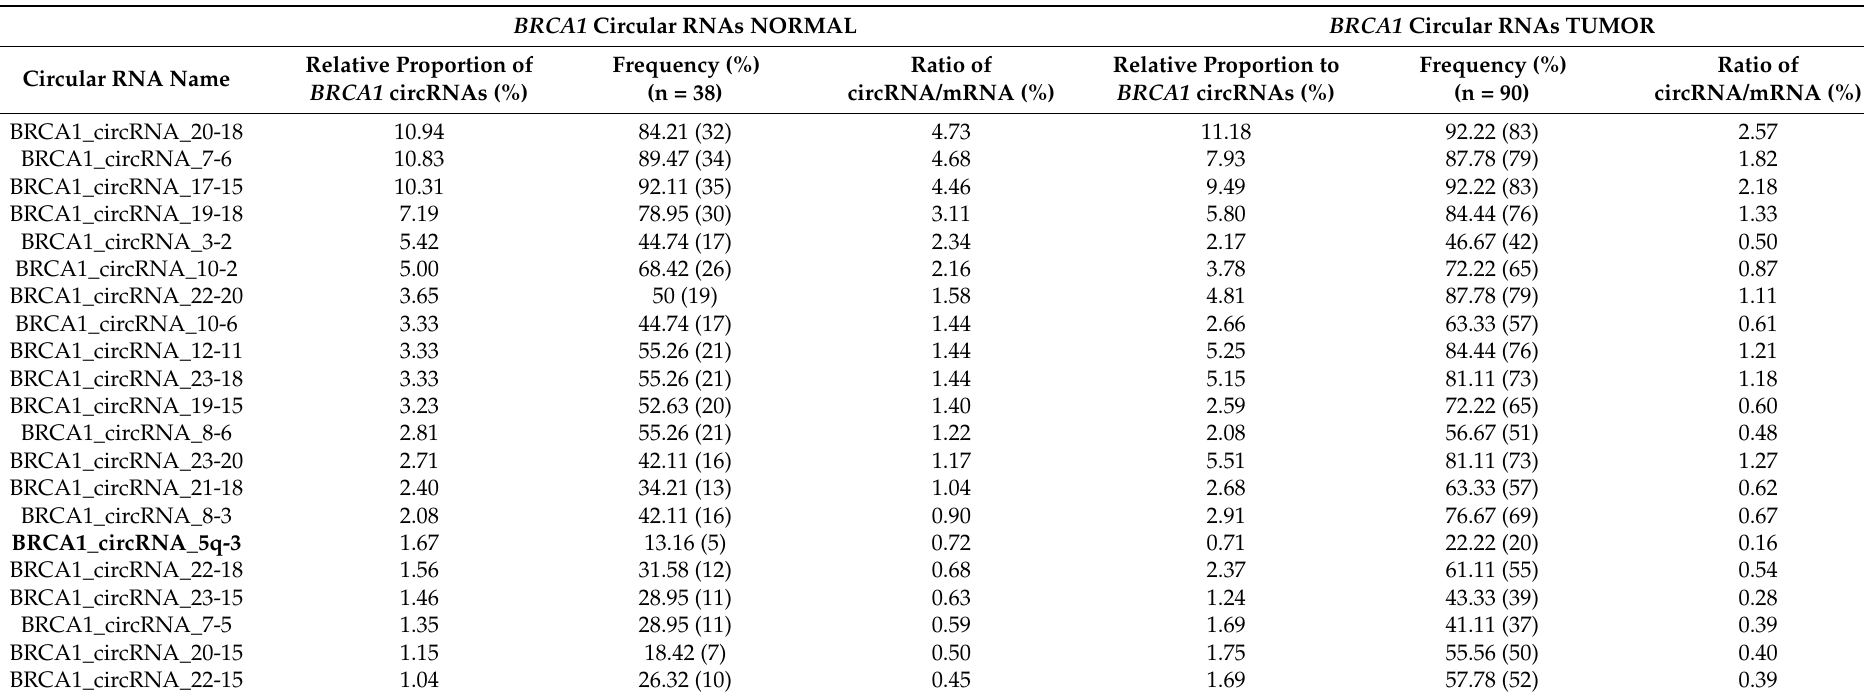
Table 1. The 20 most represented and novel BRCA1 circular RNAs in the normal and tumor breast tissues of the research set. Twenty-one circRNAs are listed as circRNA22-15 is among the 20 most represented in the tumor tissue samples, but not in the normal tissue samples. Conversely, 5q-3 is among the 20 most commonly represented circRNAs in the normal tissue samples, but not in the tumor tissue samples. The novel circRNAs are indicated in bold. BRCA1 Circular RNAs NORMAL BRCA1 Circular RNAs